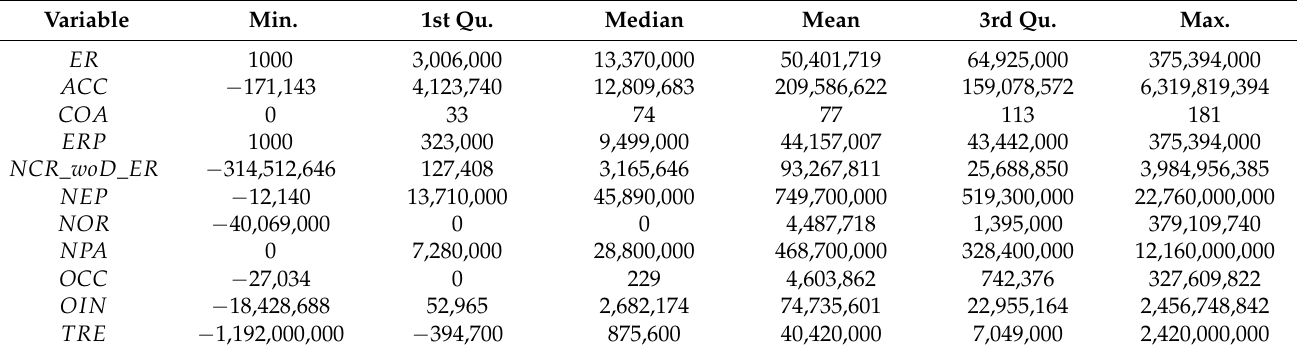
Table 8. Variable summary of non-life undertakings, observed in the years 1997 and